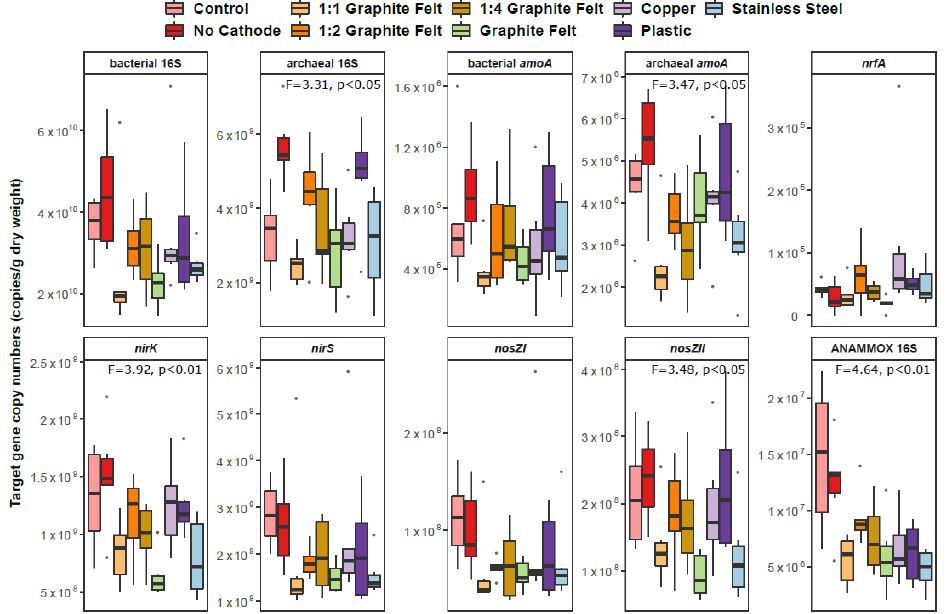
Figure 4. Box plots of target gene copy numbers in nine studied treatments (each n = 6). Statistically significant differences between groups considering different genes are shown with F and p values determined by multivariate analysis. The central line is the median, the edges of the box are the 25th and 75th percentiles, the whiskers represent the 95% confidence interval, and grey dots indicate outliers.